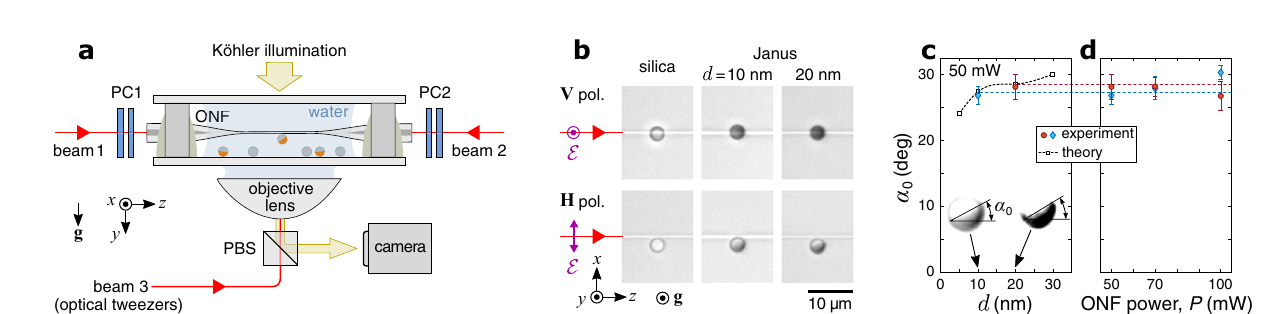
Fig. 3 | Experimental details. a Schematic of the optical setup (not to scale). A single-mode ONF is immersed in a water suspension of 3 μ m silica and Janus par- ticles which are selectively trapped and delivered to the ONF waist by low-power (1.3 − 1.7 mW) optical tweezers. Laser beams 1 and 2 produce counterpropagating modes polarized in xz - or yz -planes, corresponding to H or V polarization states of the beams. To ensure the polarization is maintained upon propagation to the ONF waist, we use adjustable compensators, PC1 and PC2, consisting of two quarter- wave plates each. The ONF and the particles are imaged by a CMOS video camera through the trapping objective under white-light illumination in Köhler